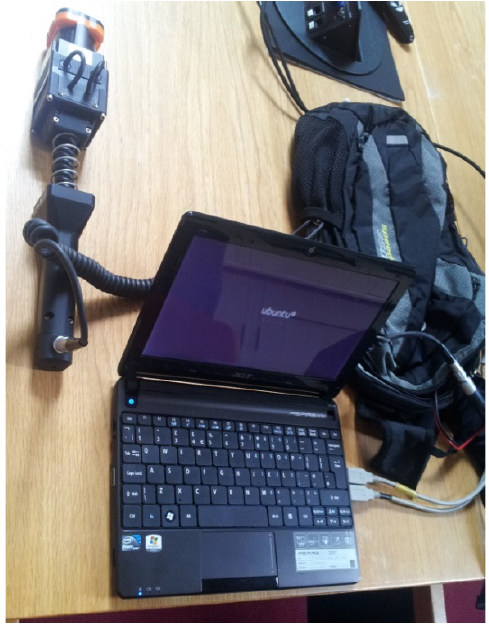
Figure 2: The ZEB1 handheld unit (left) and the control